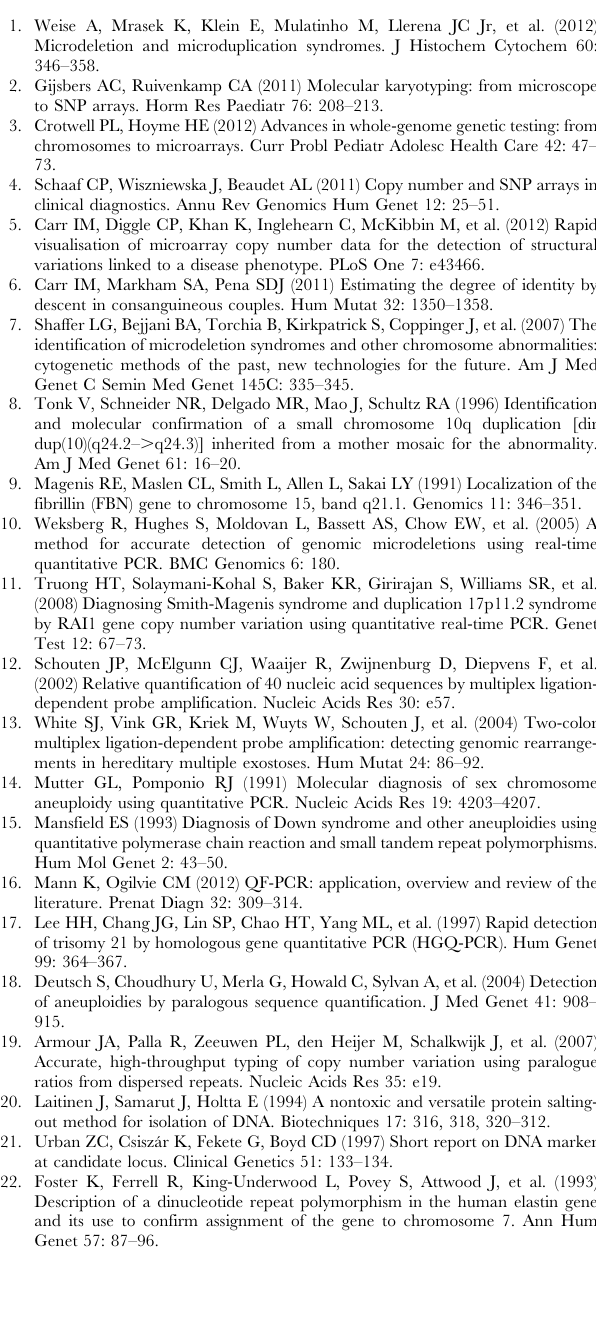
Table S1 Summary of primers used in molecular diagnosis confirmation of Williams-Beuren and Velo- cardiofacial syndromes using polymorphic microsatel- lites and Real-Time